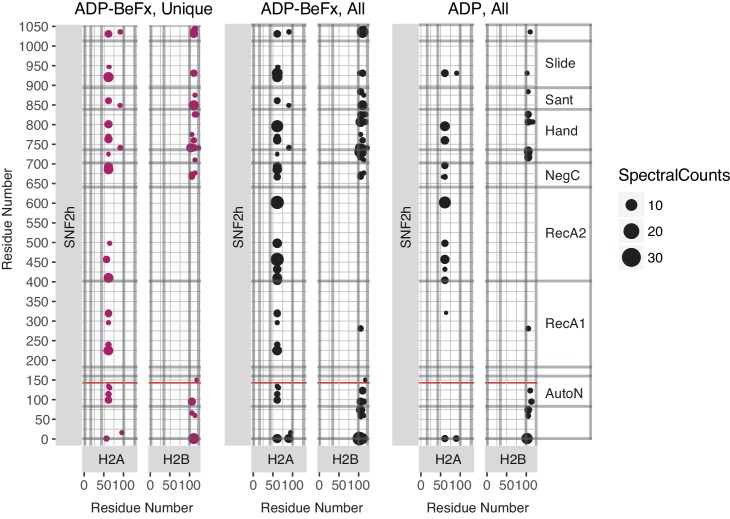
Acidic Patch-SNF2h Crosslinks Unique to the ADP•BeFx condition.Residue level cross-links between SNF2h and the H2A/H2B acidic patch. Each dot represents a pair of amino acid residues that were identified in either the ADP-BeFx experiment or the ADP experiment (right two panels, black). The left panel displays only the cross-links uniquely identified in the presence of ADP-BeFx (magenta). The area of each dot is scaled to the number of spectral counts identified. Domain boundaries are indicated by bold grey lines and labeled for SNF2h. Only cross-links to the H2A and H2B acidic patches (defined as H2A:44–100 and H2B:100–122) are plotted here for clarity. Crosslinks between H2A acidic patch and SNF2h AutoN domain are only observed with ADP-BeFx. Likewise crosslinks between the H2B acidic patch and the SNF2h NegC domain are only observed with ADP-BeFx. Positions of the 2RA mutants (R142, R144) are marked by horizontal red lines.